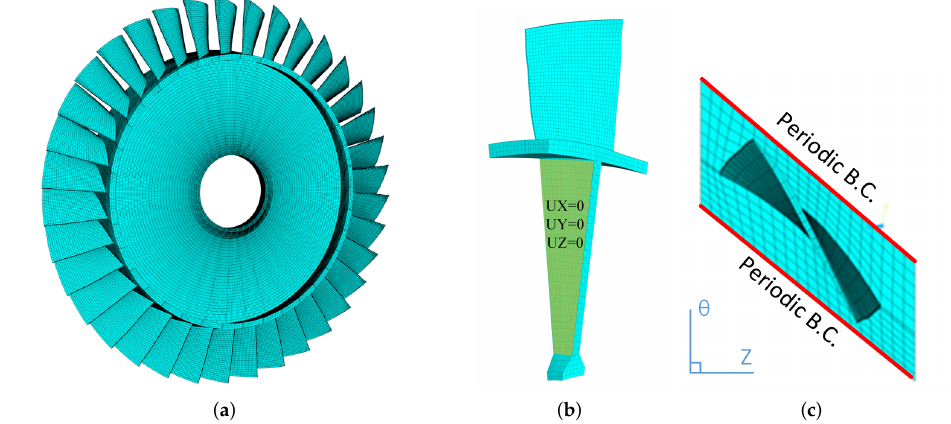
Figure 1. Finite element model of the considered bladed disk: ( a ) overall mesh, ( b ) blade sector, ( c ) periodic boundaries. Table 1. Fluid working parameters of NASA-ROTOR37 blades.